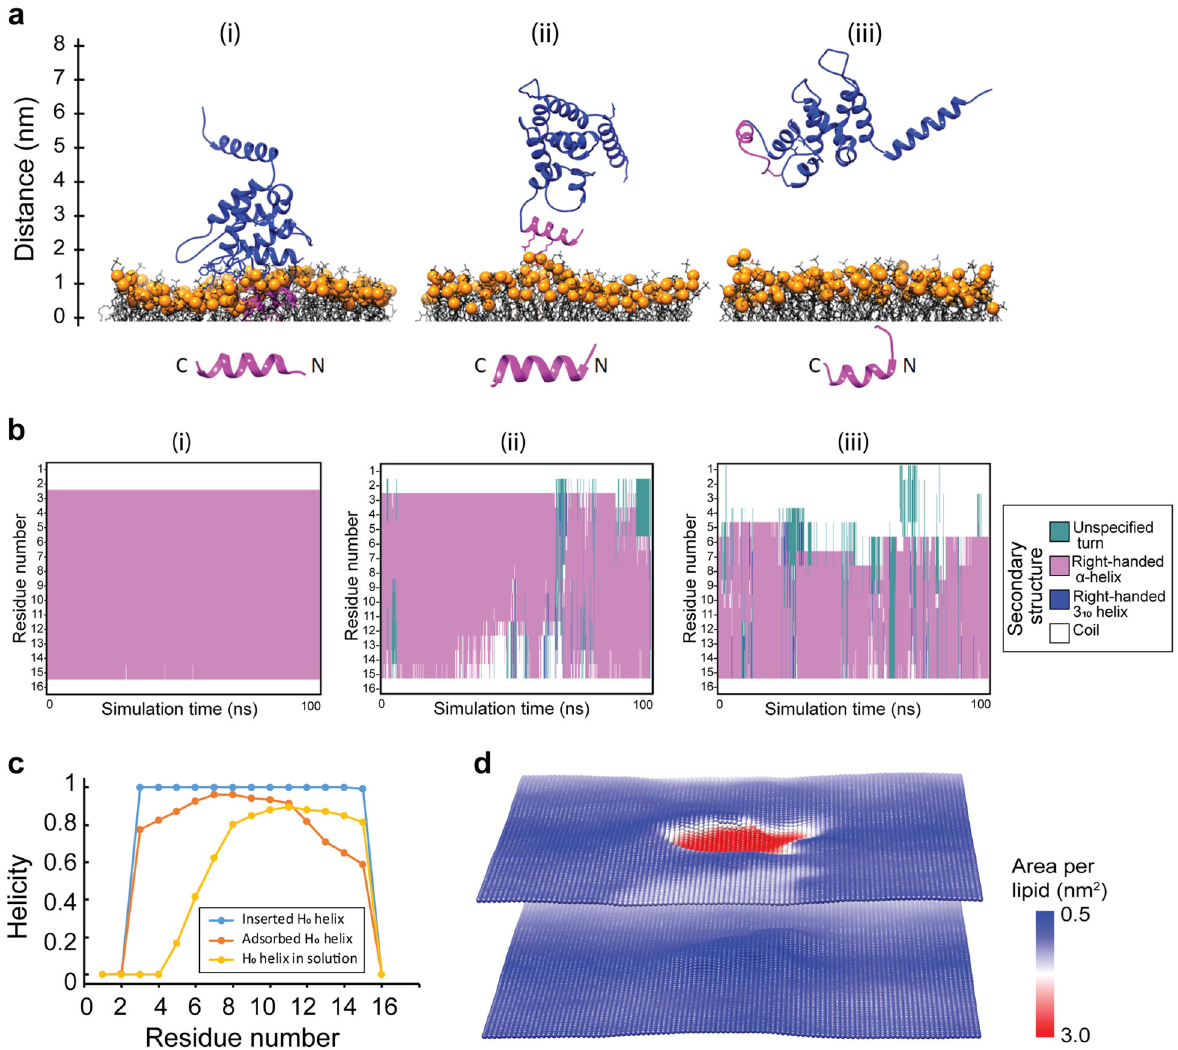
Fig. 4 Atomistic insights into ENTH-membrane interactions. a ENTH domain interacting with POPC membrane with a single PIP 2 lipid and pulled out of the membrane. The H 0 helix shown in magenta is in the inserted (i), adsorbed (ii) and solvent (iii) states. b Secondary structure analysis of each residue of H 0 in the three states shown in ( a ). c The summary of the analysis in ( b ). The helicity of H 0 decreases as it undergoes reduced interactions with the membrane. The protein – lipid interactions stabilize the alpha-helix structure of H 0 . d The area per lipid plot corresponding to the inserted state shown in ( a ). The POPC lipids have a typical area of 0.64 nm 2 . The presence of H 0 displaces lipids in the top lea fl et. As a result, the effective area per lipid increases in the H 0 -occupied domain (red